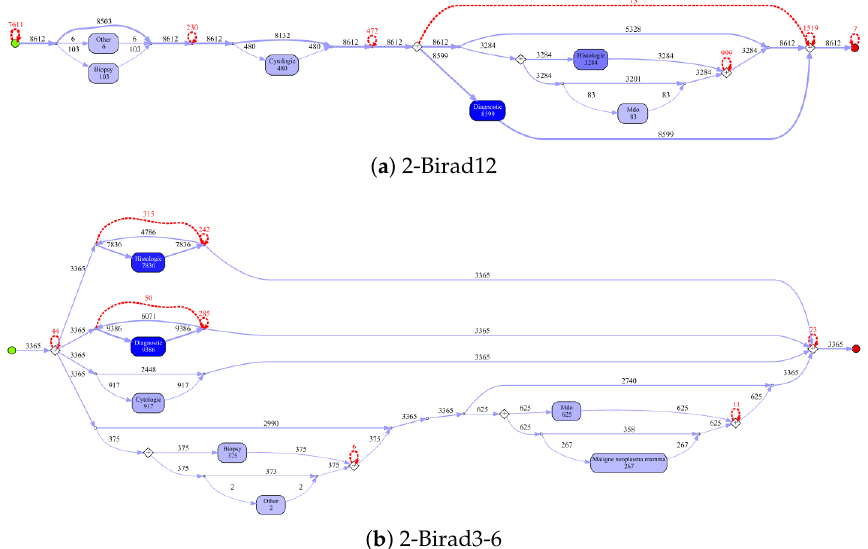
Figure 10. Discovered process models on ZGT for sub-populations with second-level